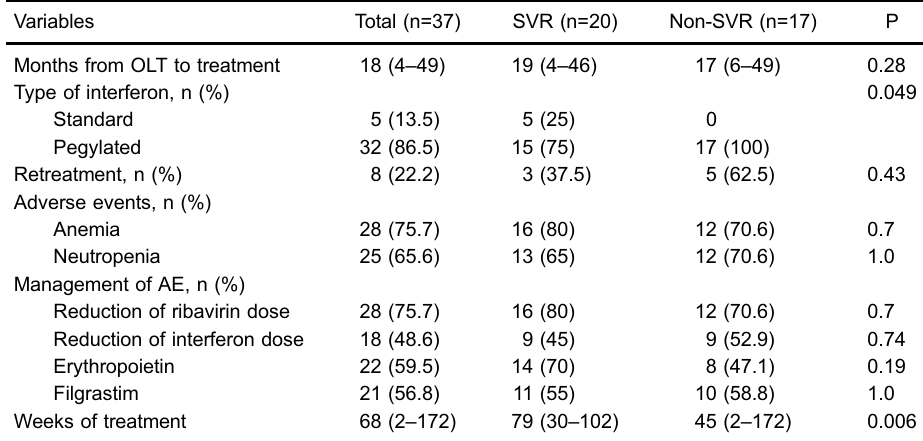
Table 3. Recurrent HCV treatment characteristics of patients after orthotopic liver transplantation.